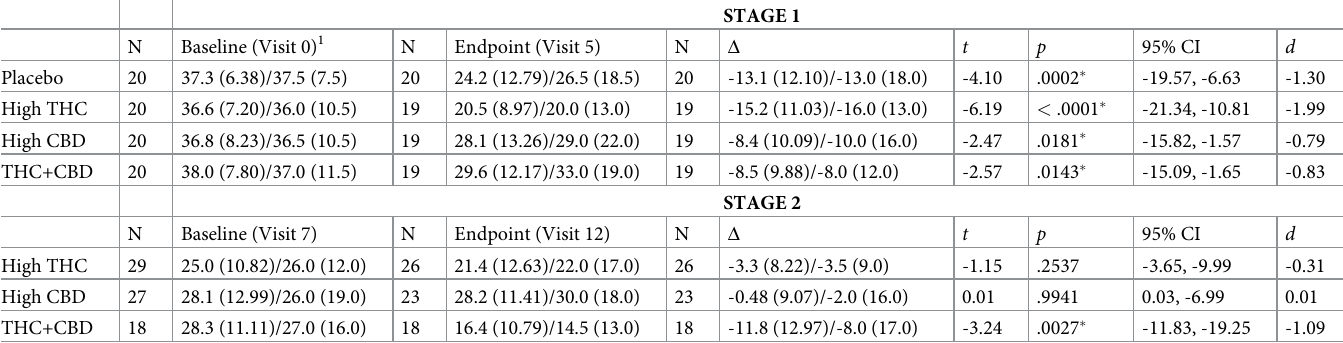
Table 4. Mean (SD)/Median (IQR) and analysis of change in CAPS-5 total severity scores by treatment & stage.